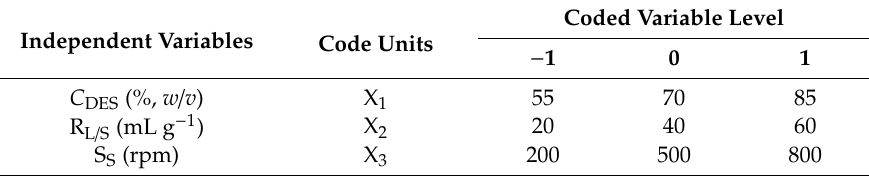
Table 1. Actual and codified levels of the variables used for the design of